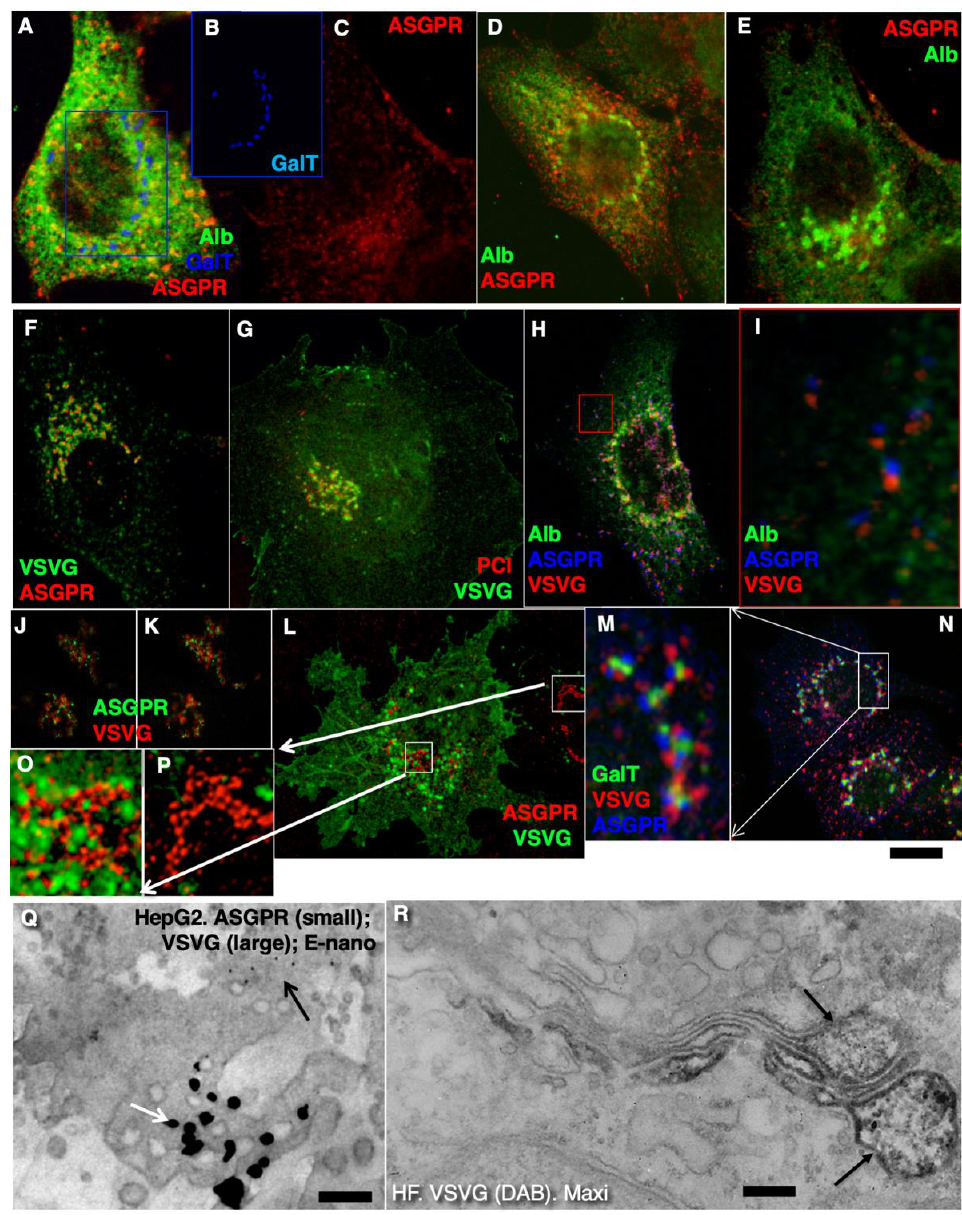
Figure 9. During intra-Golgi transport, different membrane cargoes form distinct domains. ( A – C ) Flu- orescence microscopy. HepG2 cells are shown after the 15 ◦ C temperature block. Albumin (green) is in the ER, ASGPR (red; ( C )) is in the ER exit sites. ( B ) Labelling for GalT (blue) in the Golgi complex appears to be centrally fragmented. ( D ) At 2 min after release of the 15 ◦ C temperature block, part of the albumin is in the Golgi complex, whereas ASGPR remains in ER exit sites. ( E ) Labelling for ASGPR (red) and albumin (green) at 4 min after release of the 15 ◦ C temperature block. Albumin (green) is concentrated within the Golgi complex. ( F , H – P ). Fluorescence microscopy. In HepG2 cells infected with tsVSV and synchronised according to the CHM-15-CHM protocol, VSVG and ASGPR form distinct dots at 5 min after release of the block. ( G ) In human fibroblasts infected with tsVSV, stimulated to synthesise PCI and incubated at 32 ◦ C, PC and VSVG form distinct dots. ( Q ) Double silver enhancement. Distinct aggregates of different gold particles. ( R ) When the maxi-wave protocol was applied, VSVG (DAB) was present in the membrane surrounding PCI distensions (arrows). Scale bars: 2 µ m ( A – G ); 4 µ m ( H ); 5 µ m ( L , N ); 180 nm ( C , Q ); 280 nm ( R ).